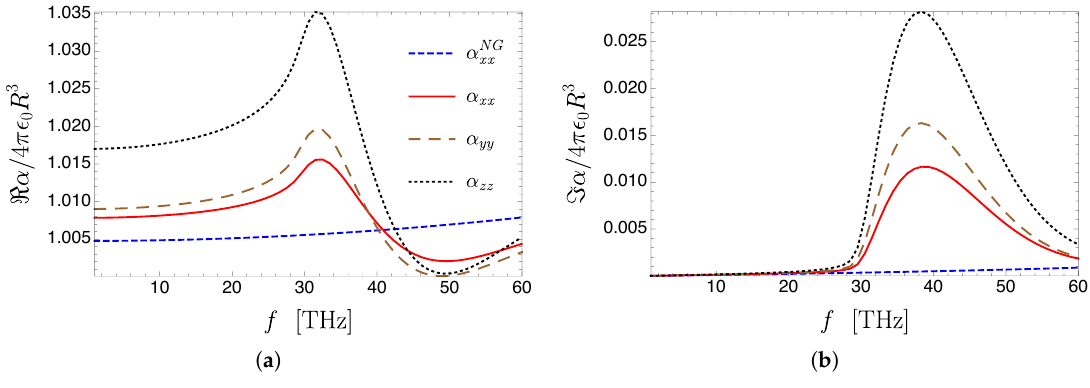
Figure 6. Real ( a ) and imaginary ( b ) renormalized polarizability of a gold nanoparticle in close proximity to a plasmonic graphene-based grating. The solid red line represents the xx component of the polarizability in the presence of graphene, the dashed brown line represents the yy component, and the black dotted line represents the zz component. The dashed blue line is the xx component of the polarizability in the absence of graphene. Note that α xx (cid:54) = α yy , due to lack of rotational symmetry in the xy − plane introduced by the ribbon structure. The parameters of the grating are L = 0.5 µ m and w = L /2. The parameters for the graphene conductivity and for the Drude dielectric function of gold are the same as in Figure